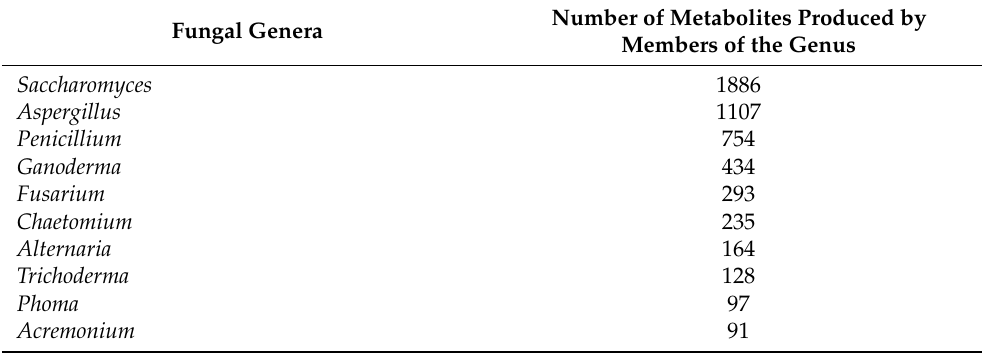
Number of Metabolites Produced by Members of the Species